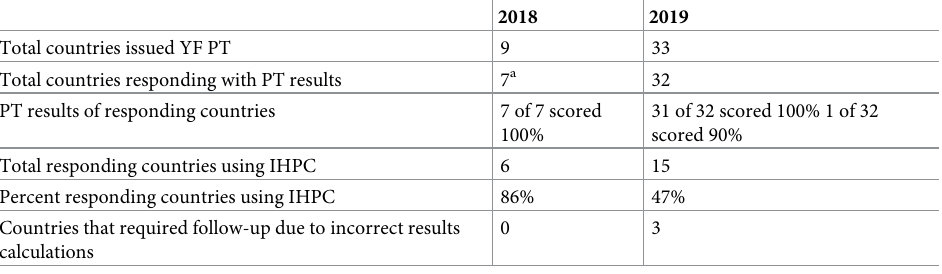
Table 1. Results Summary of 2018 and 2019 Yellow Fever Proficiency Testing Exercises Performed by Laborato- ries in Yellow Fever Endemic Regions based on correctly identified positive or negative